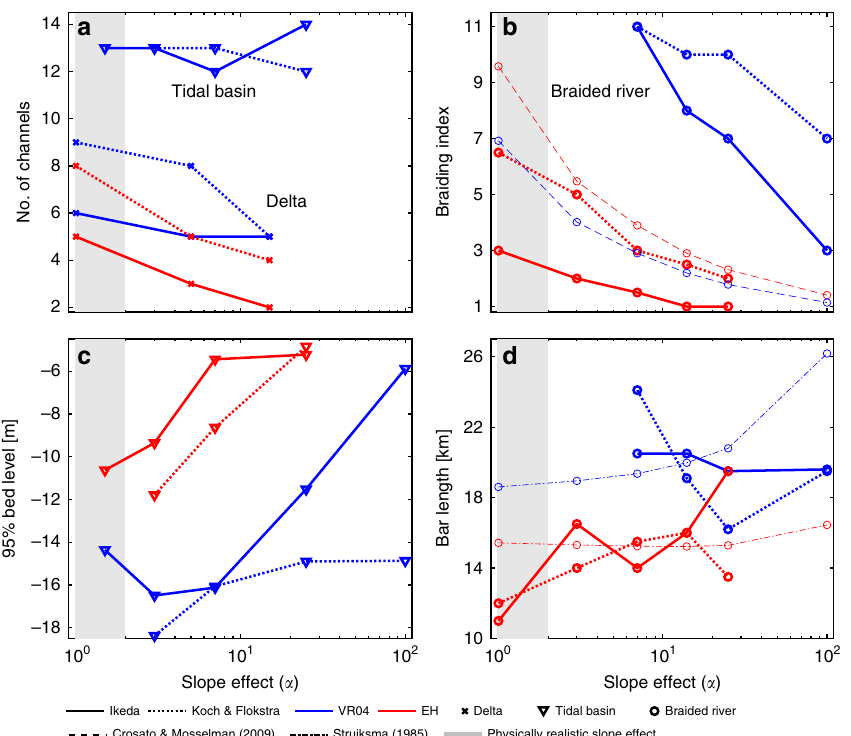
Fig. 7 Relation between slope effect and morphodynamic element dimensions. a Number of channels at the delta front in the delta models, and the number of channels in the tidal basin models, against increasing slope effect. b Braiding index with increasing slope effect in the braided river model, with the semi- analytical predictor for braiding index from Crosato and Mosselman 32 in corresponding colors for comparison. c The 95% depth of all tidal channels in the tidal basin models against slope effect. d Mean bar length in the braiding river model when increasing the slope effect, including the predictor of Struiksma and others 29 for wave lengths of bars. Braiding index and bar length are computed according to the methods described in Schuurman et al. 9 . The method of determining the number of channels in the tidal basin models is explained in the “ Methods ” section. Slope effect is given as the α transformed for